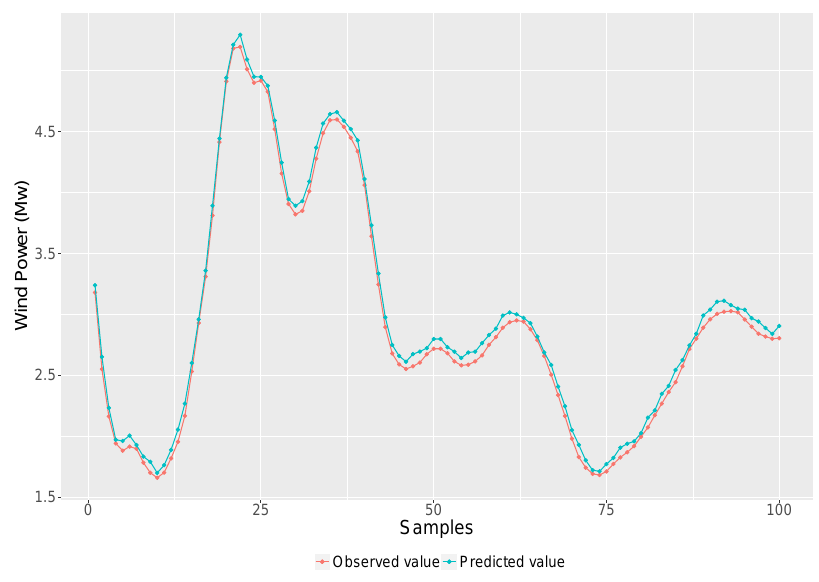
Figure 7. Comparison of observed and predicted values of a whole one-year dataset (initial 100 samples). Table 7. Comparison of proposed methodology with contemporary methods for a whole one-year